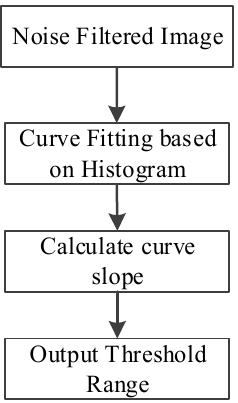
Figure 3. Flowchart of threshold range prediction (TRP).